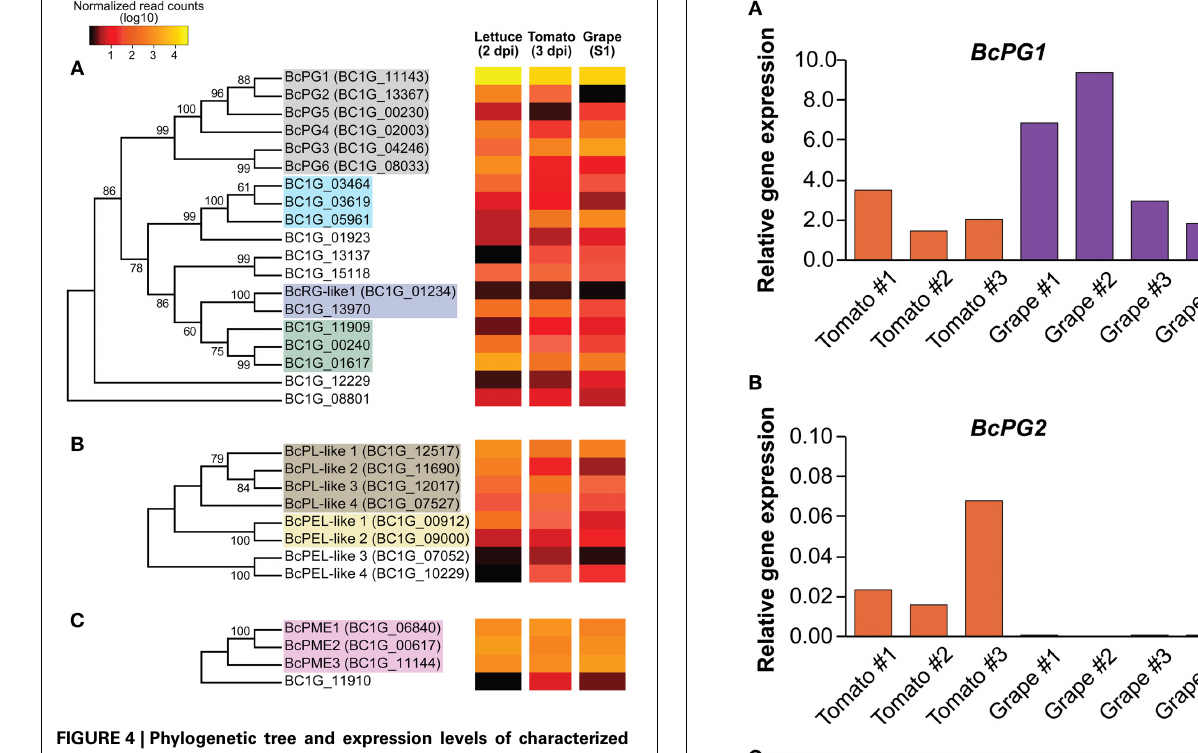
xylan backbones, thus assisting, their subsequent degradation by hydrolytic enzymes. BcCutA gene was highly expressed ( > 0.45% of reads) by Botrytis in fruit tissues ( P- adjusted value < 0.001),